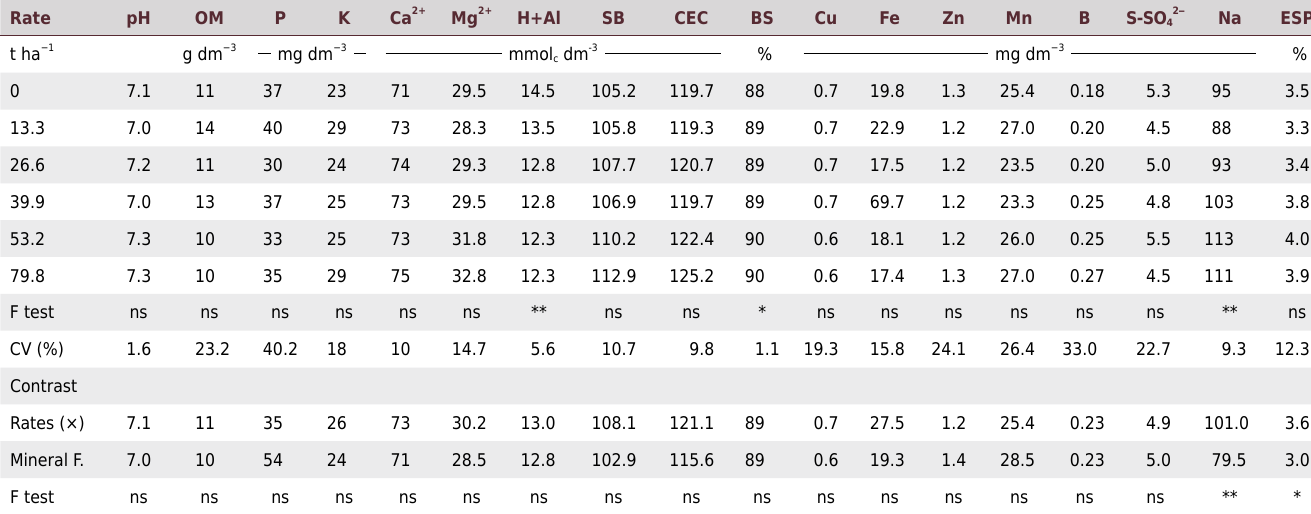
Table 5. Mean values, F test, and coefficient of variation for soil chemical properties in the 0.20-0.40 m layer, in response to organic compost rates applied to elephant grass Rate pH